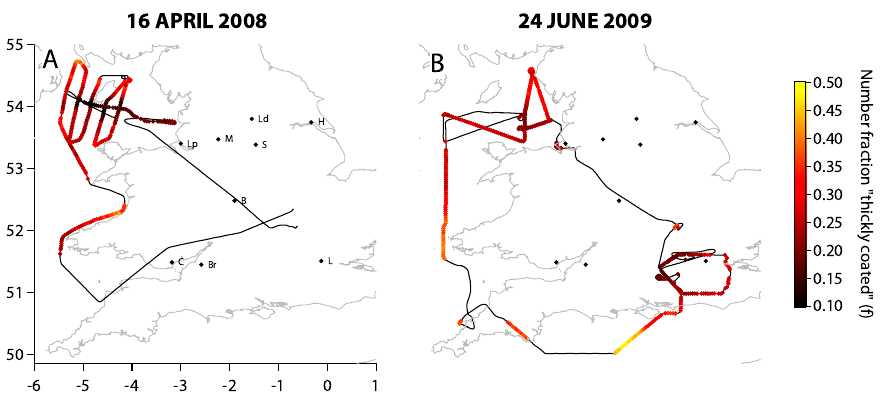
Fig. 6. Maps showing the number fraction of thickly coated rBC particles determined from a time delay analysis of single particle incandes- cence and scattering signals for 16 April 2008 and 24 June 2009.